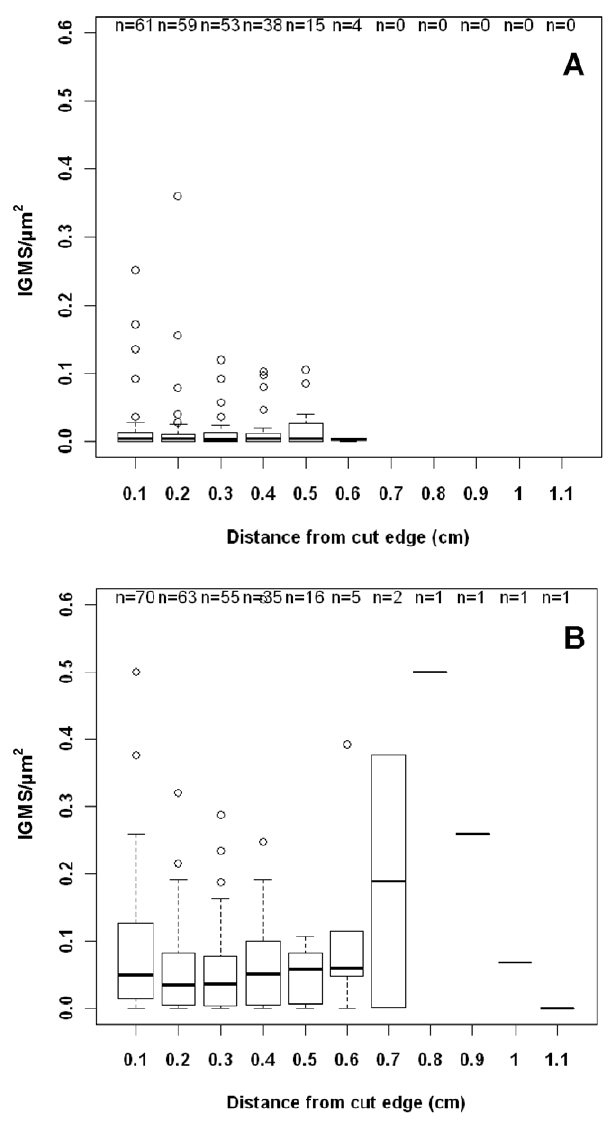
Figure 2. Box-whisker plots of invasive gastrovascular multi- cellular structures (IGMS)/ m m2 with distance from broken fragment edge of normal tissues (A) or distance from edge of lesion in tissues manifesting WS (B). Sample size indicated above each box. Bold line indicates median, lower and upper margin of box are first and third quartile, lower and upper whiskers indicate lowest and highest data point within 1.5*interquartile range, respectively, and dots indicate outliers.